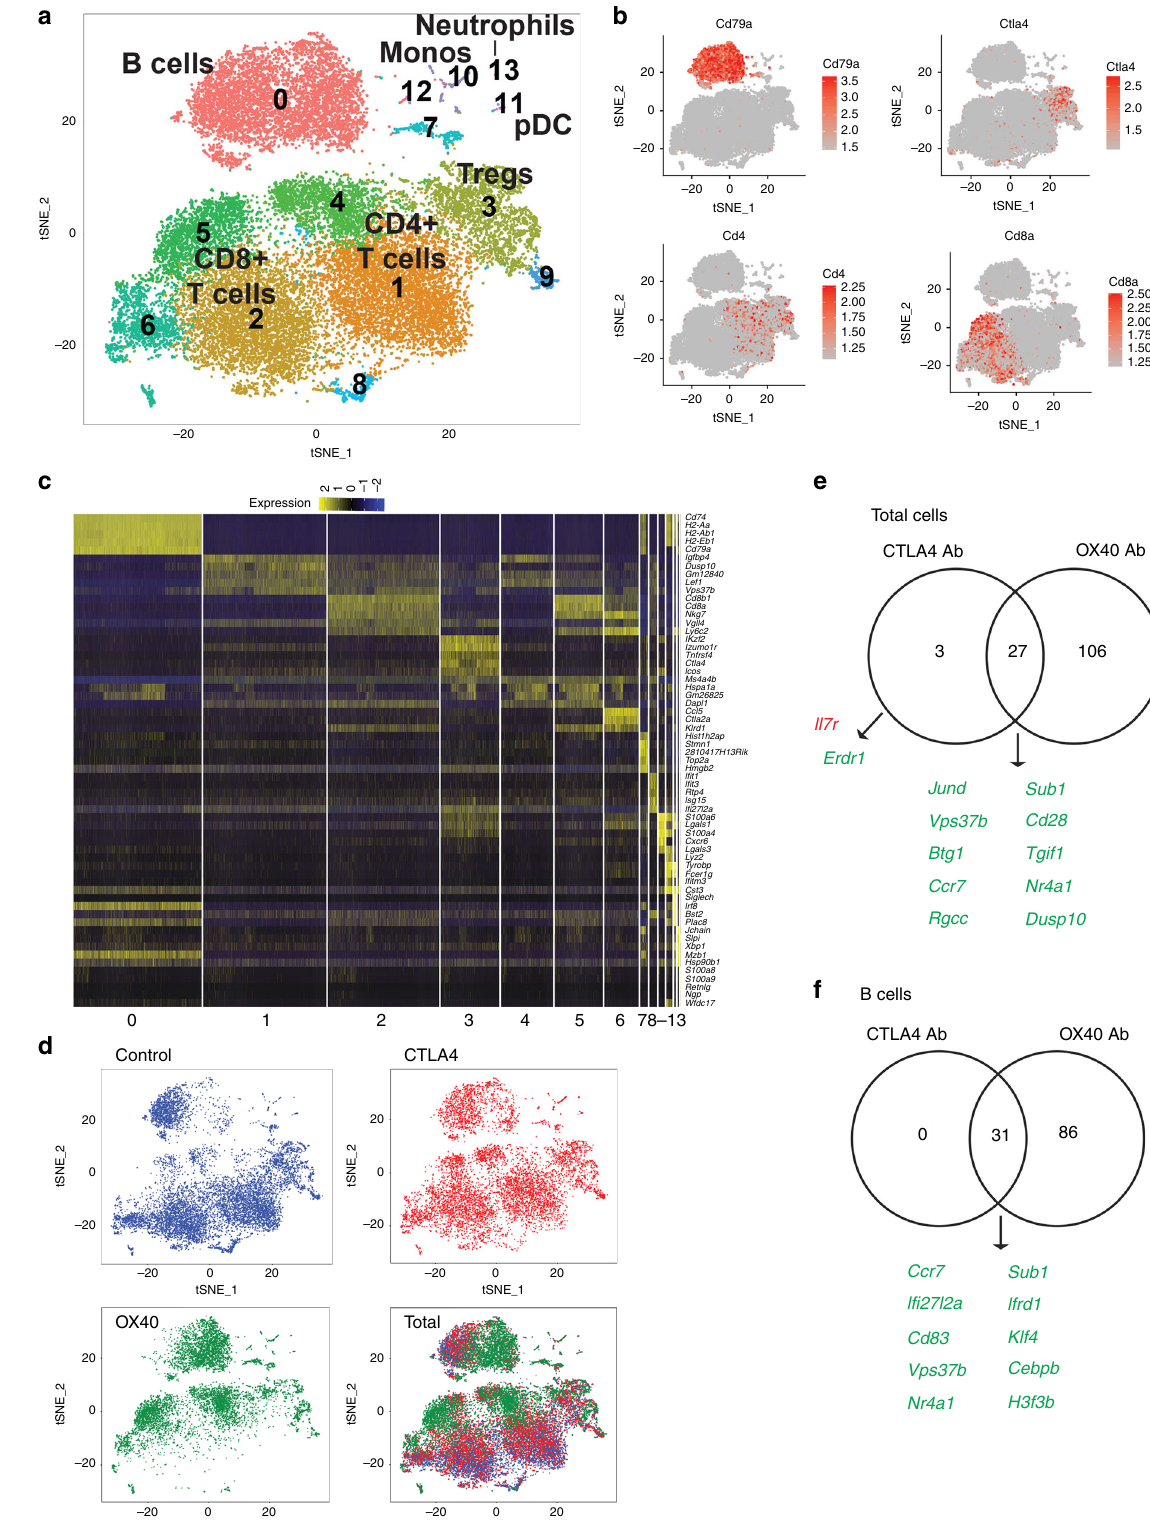
dendritic cells, and neutrophils (Fig. 7b, c). Cells within immune cell clusters from the CTLA-4 Ab (red) and control antibody- treated (blue) mice clustered near each other, indicating overall similarity of the individual cell transcriptional pro fi les (Fig. 7d). In contrast, cells from the OX40 Ab-treated mice (green) formed